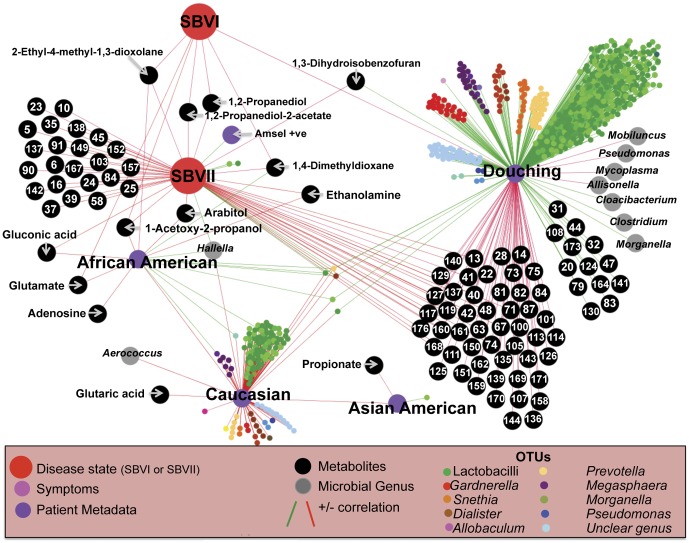
SBVII Sub-Network View of Linear Relationships among Variables.Pearson's (between parametric data) and Spearman's (between non-parametric and either parametric or non-parametric data) correlations >0.6 (green) or <−0.4 (red) are shown as edges connecting patient metadata relating to demographics, hygiene and sexual behaviors and sexual practices, OTUs, microbial genera, metabolites and patient symptoms. Figures presented represent sub-networks of the complete network (Fig S2). Node identities are listed or described in the key. The identities of numbered metabolites are listed in Table S2.